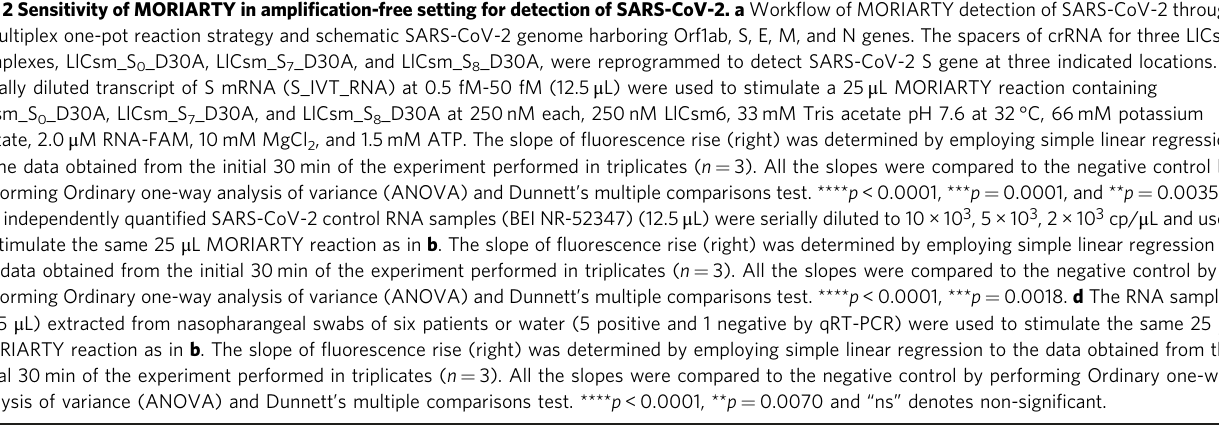
Fig. 2 Sensitivity of MORIARTY in ampli fi cation-free setting for detection of SARS-CoV-2. a Work fl ow of MORIARTY detection of SARS-CoV-2 through a multiplex one-pot reaction strategy and schematic SARS-CoV-2 genome harboring Orf1ab, S, E, M, and N genes. The spacers of crRNA for three LlCsm complexes, LlCsm_S 0 _D30A, LlCsm_S 7 _D30A, and LlCsm_S 8 _D30A, were reprogrammed to detect SARS-CoV-2 S gene at three indicated locations.